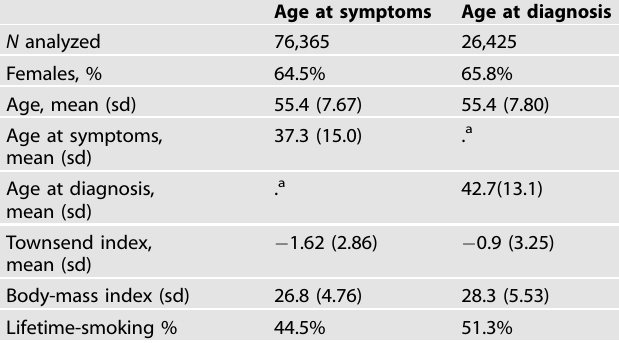
Table 1. Participant